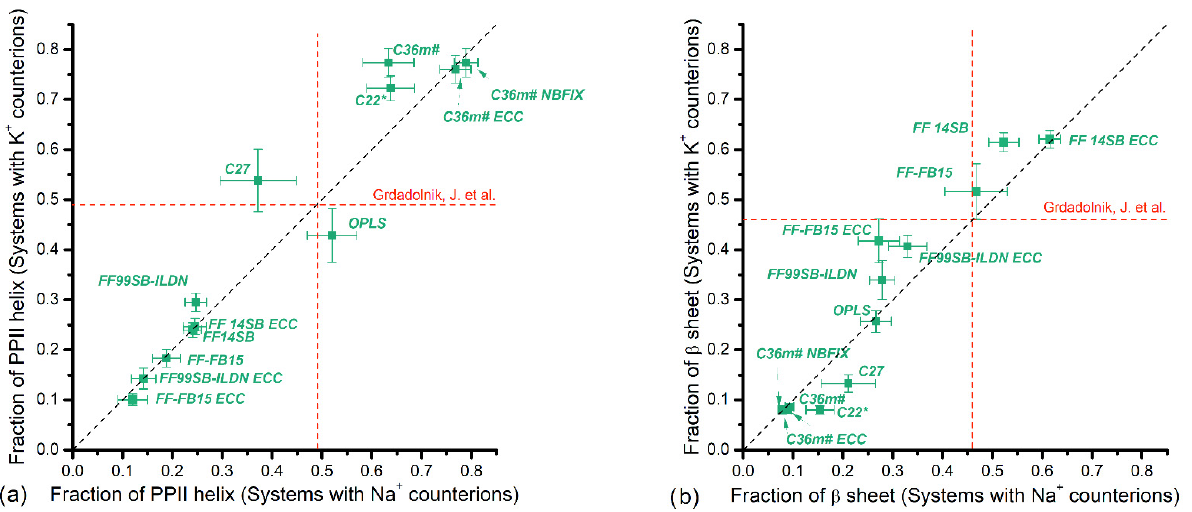
Figure 5. PASA: Fractions of ( a ) PPII helices and ( b ) β -sheet conformations with Na + vs. K + counter- ions. Vertical and horizontal dashed lines correspond to available experiment data.